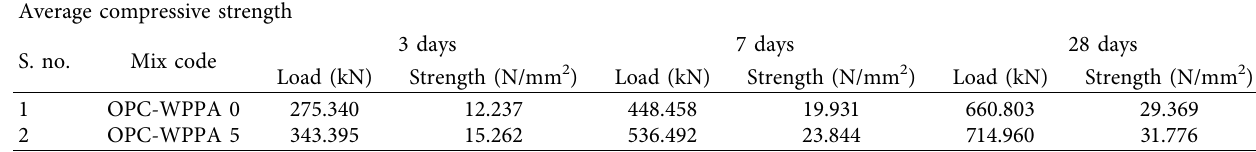
Table 1: Pretest result for compressive strength of C-25 concrete.